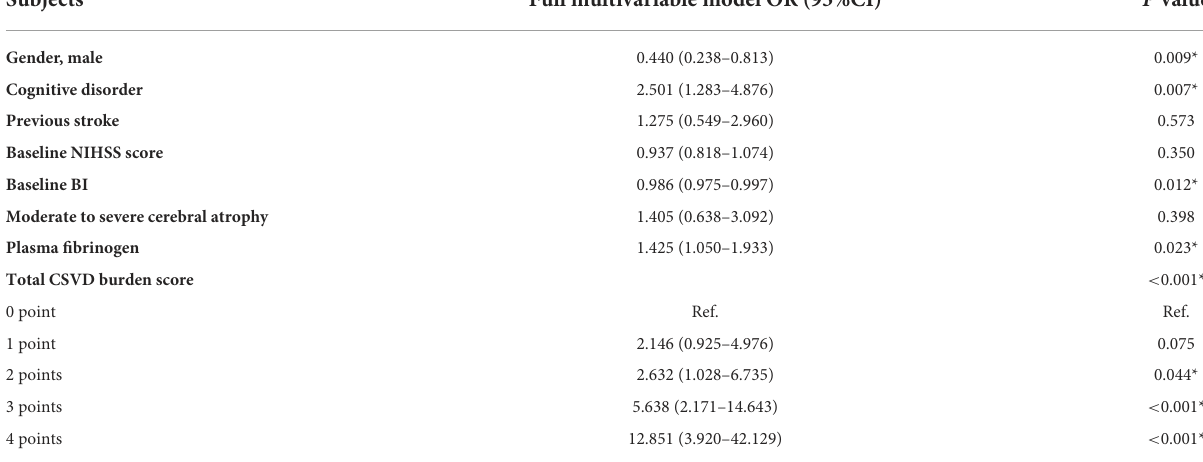
TABLE 3 Multivariable logistic regression of early-onset